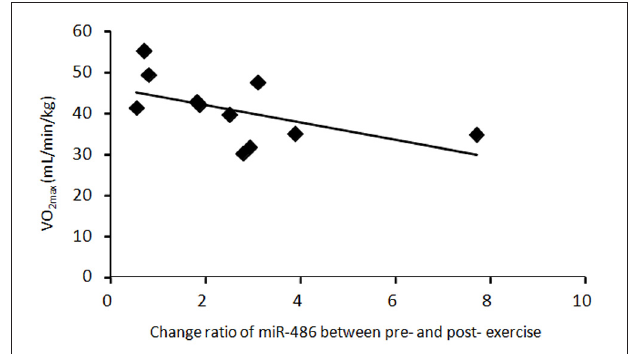
FIGURE 4 | The relationship between c-miR-486 and VO 2max . Change ratio of miR-486 between before and after a single bout of exercise and VO 2max values were plotted for each of 11 subjects. There was a significant negative correlation between the change ratio of circulating miR-486 (normalized to miR-16) after acute exercise and VO 2max ( R = 0 . 58, P = 0 .